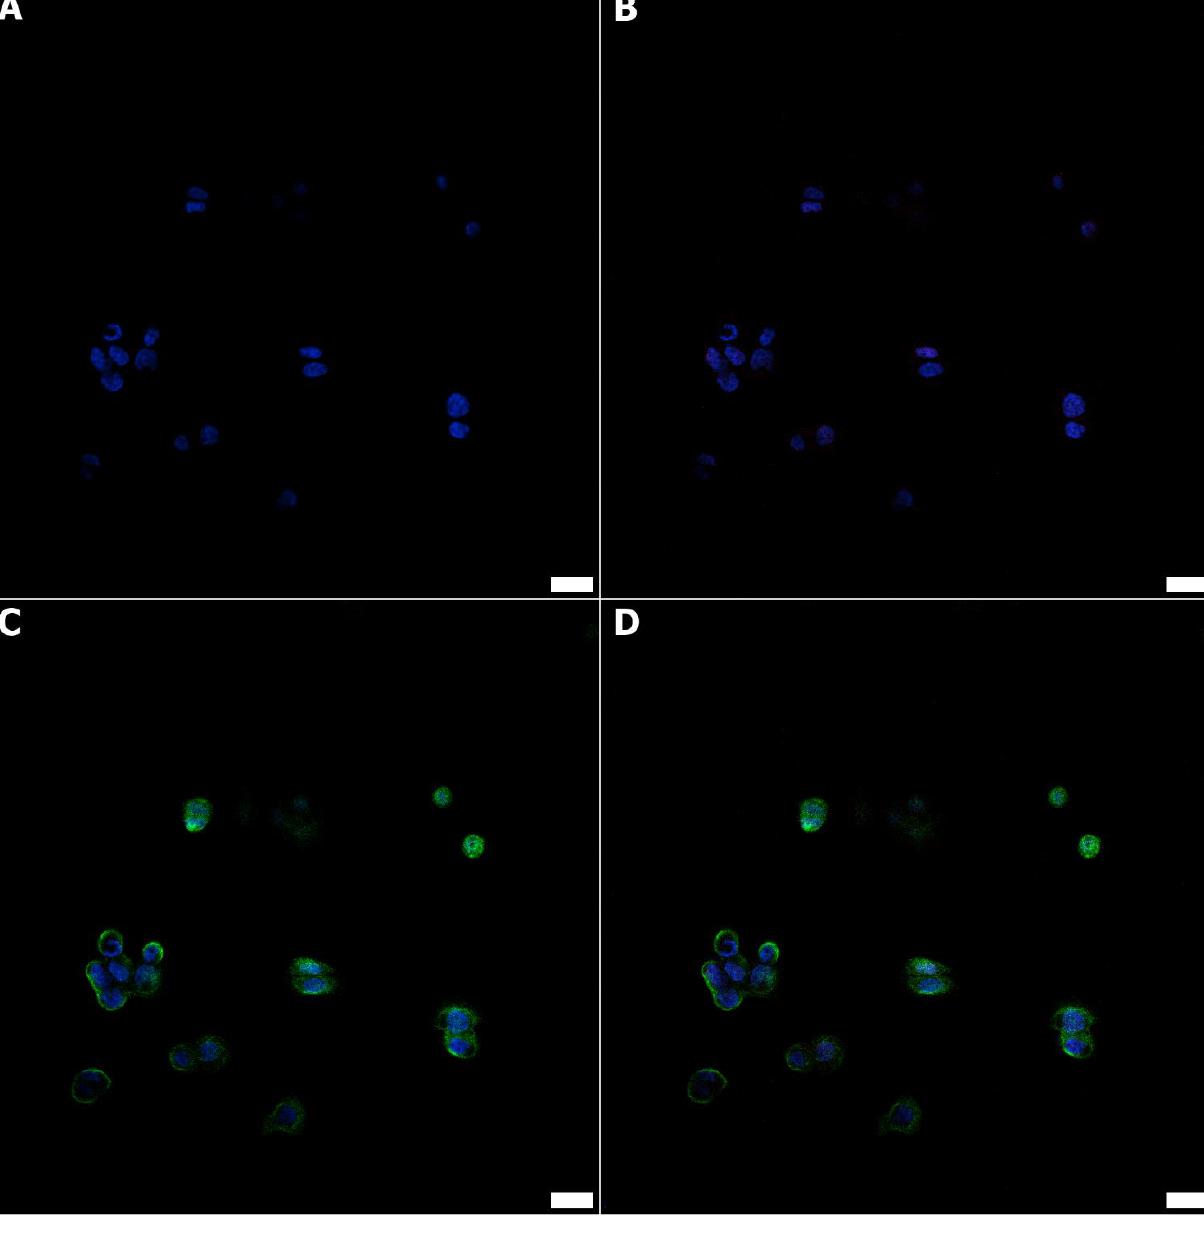
Figure 2. The immunofluorescence labeling against HIF1 α (red) showed positive nuclear expression in hypoxic HT-29 cells ( B , D ). All hypoxic cells were positive on β -actin (green, ( C , D )) and DAPI (blue nuclei, ( A – D )); scale bars = 20 μ